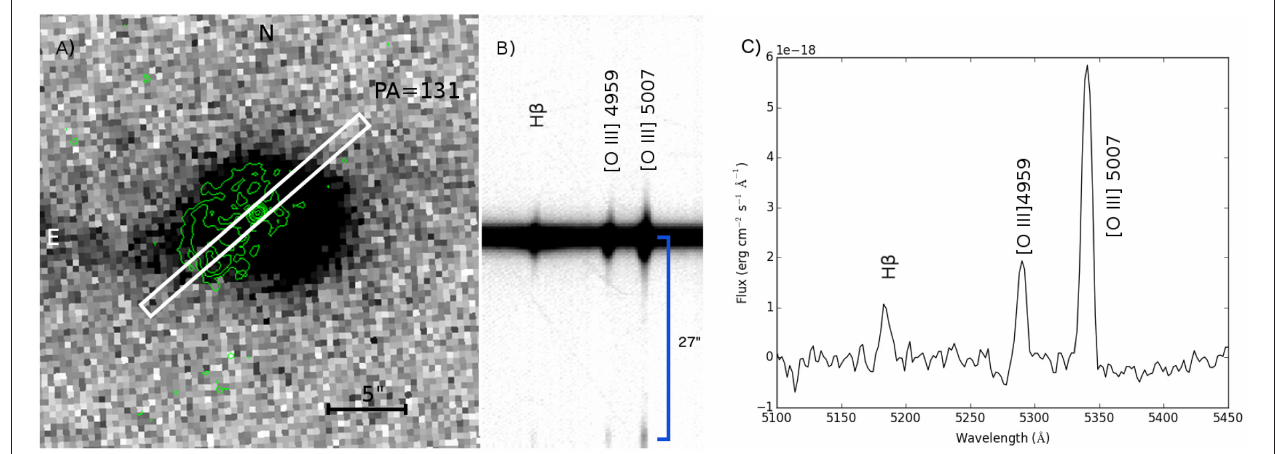
FIGURE 1 | From left to right: (A) SDSS g-band image of Mrk 783 with the contours of the emission at 5GHz. The contours are 3,6,12,24,48,96, and 192 × σ ( σ = 11 µ Jy beam − 1 ). The beam size is 0.45 × 0.40arcsec and the scale is 1.3kpcarcsec − 1 . The position of the slit used for the observations with the Magellan telescope is shown. The galaxy is characterized by a radio emission with a maximum extension of ∼ 5arcsec on the south-east side of the nucleus ( Congiu et al., 2017a ). (B) A small region of the LDSS3 spectra of Mrk 783 containing three emission lines: H β , [O III] λ 4959 and [O III] λ 5007. The data were acquired with a total exposure time of 1 h, with a seeing of 0.8arcsec and the slit oriented as in (A) . The spatial resolution is 0.189arcsec px − 1 and the dispersion is ∼ 2Åpx − 1 . (C) Plot of the spectrum in (B) at 27arcsec from the galactic nucleus.